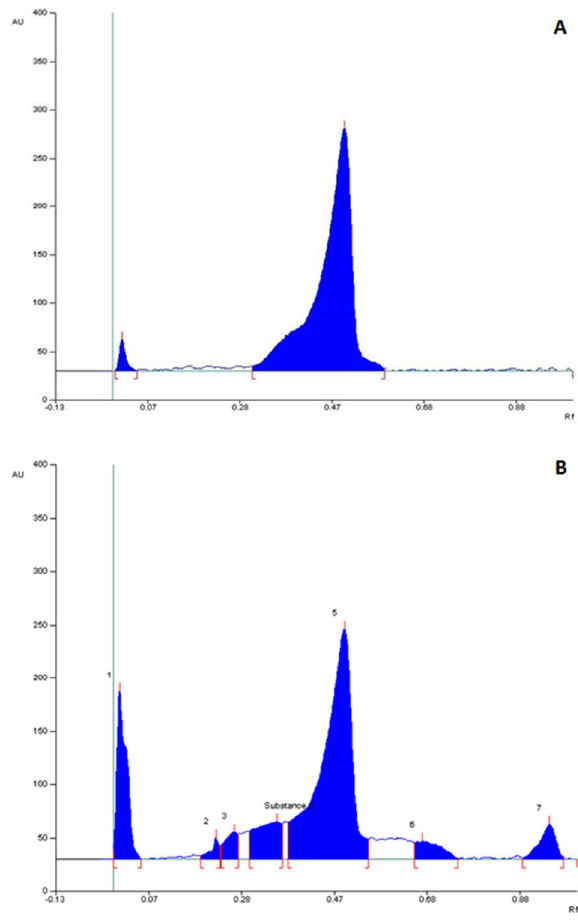
Figure 1. HPTLC profile of quercetin ( A ) and HPTLC profile of chloroform fraction D (QTN) of MI-ALC (B). Eluent–toluene: ethyl acetate: formic acid (6: 3.5: 0.5) (v/v/v). The detection was at 370 nm.